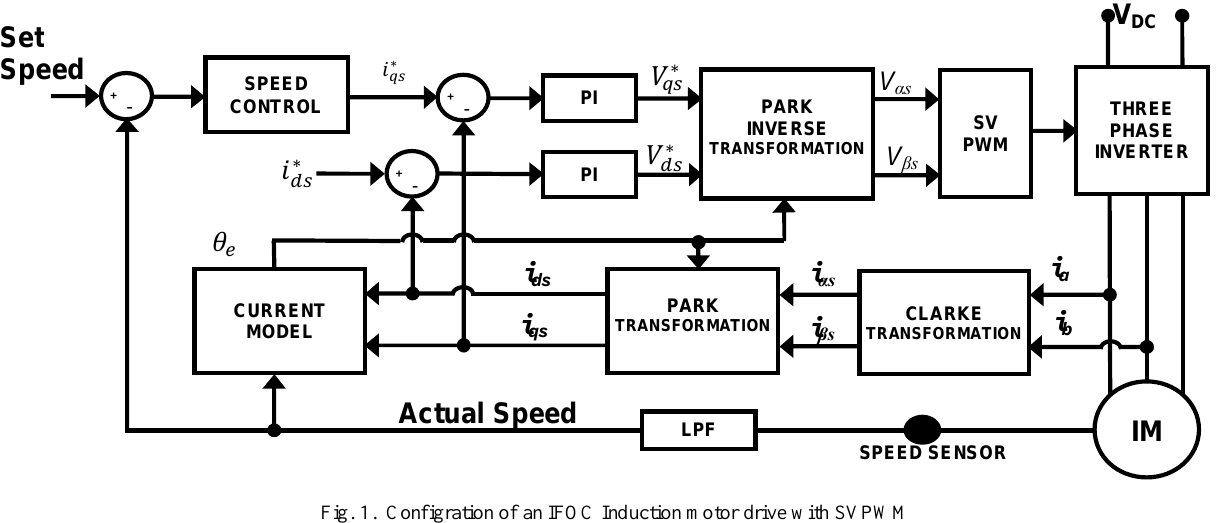
Fig. 1. Configration of an IFOC Induction motor drive with